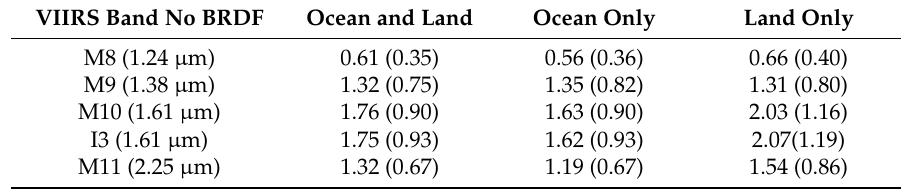
Table 2. Comparison of temporal standard error in percent for VIIRS SWIR bands using the no BRDF correction for tropical ocean and land, ocean-only, and land-only. The standard errors in parenthesis are after